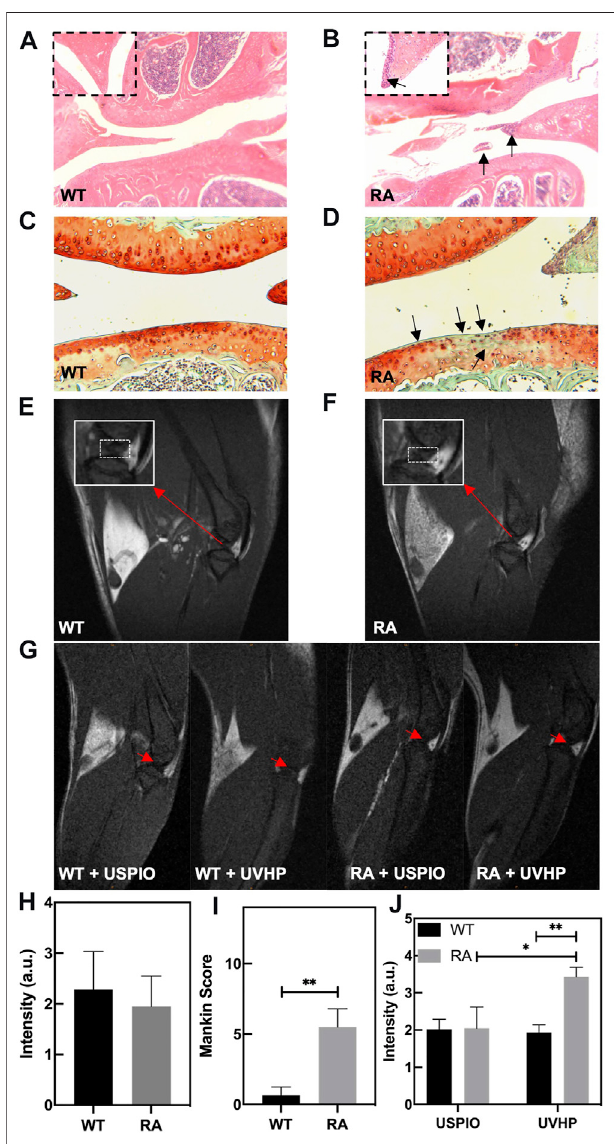
FIGURE 5 | Photomicrographs of representative hematoxylin and eosin (H&E) – stained sections of knee joint from WT mice (A) and RA mice (B) . The arrow shows the in fi ltration of in fl ammatory cells. (C,D) Safranin O/fast green staining sections of knee joint from WT mice (C) and RA mice (D) . The arrow showsthe cartilagelayer lesion area. (E,F) T 1 -weighted MRIoftheknee joint in WT and RA mice; red arrows indicate the site of interest. (G) T 1 - weightedMRIofthekneejointinWTandRAmiceinjectedwithUVHPthrough the tail vein, at the same time WT and RA mice injected with USPIO in the tail veinas controls; red arrows indicate the site ofinterest. (H) MRI signal valueof T 1 -weightedMRIofthekneejointinWTandRAmice. (I) Mankinscoreofknee jointsinWTand RAmice. (J) SignalvalueofT1-weightedMRIofthekneejoint in WT and RA mice injected with USPIO and UVHP,